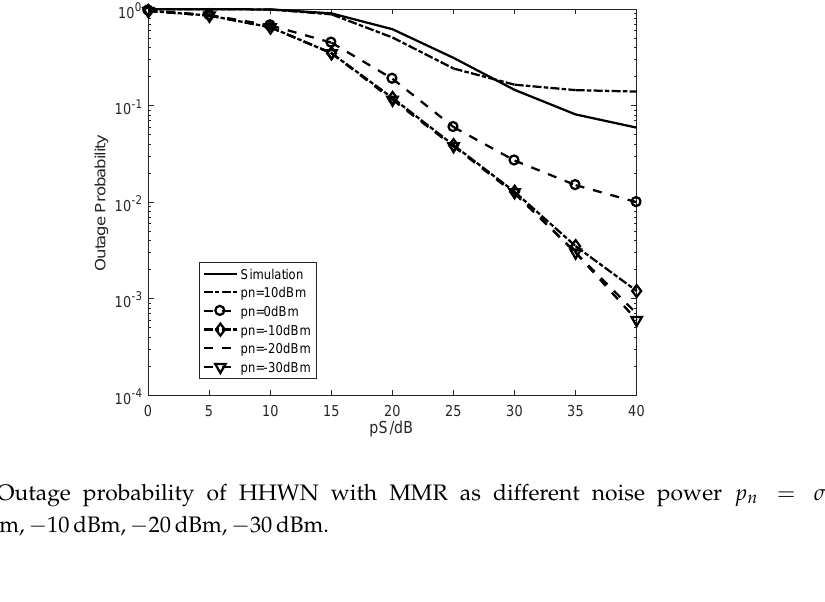
Figure 9. Outage probability of HHWN with MMR as different noise power p n = σ 2 10dBm,0dBm, − 10dBm, − 20dBm, −